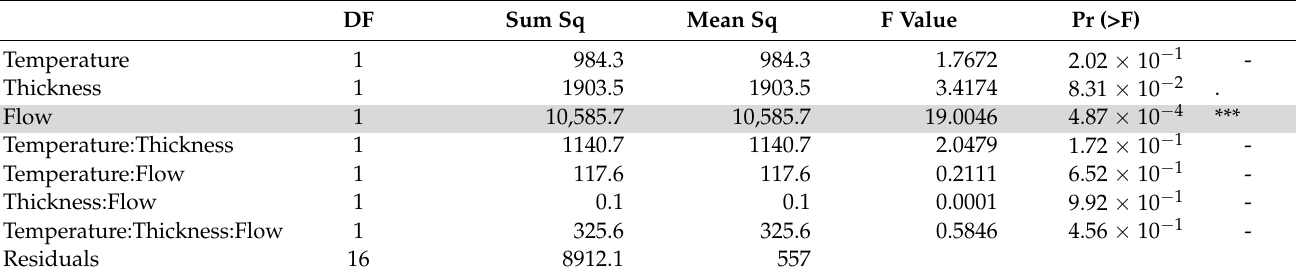
Figure 7. Tensile modulus, yield and tensile strength and strain at maximum strength of the eight printing configurations under study. Table 8. Statistical significance of the effects of the printing parameters and their interactions on samples tensile